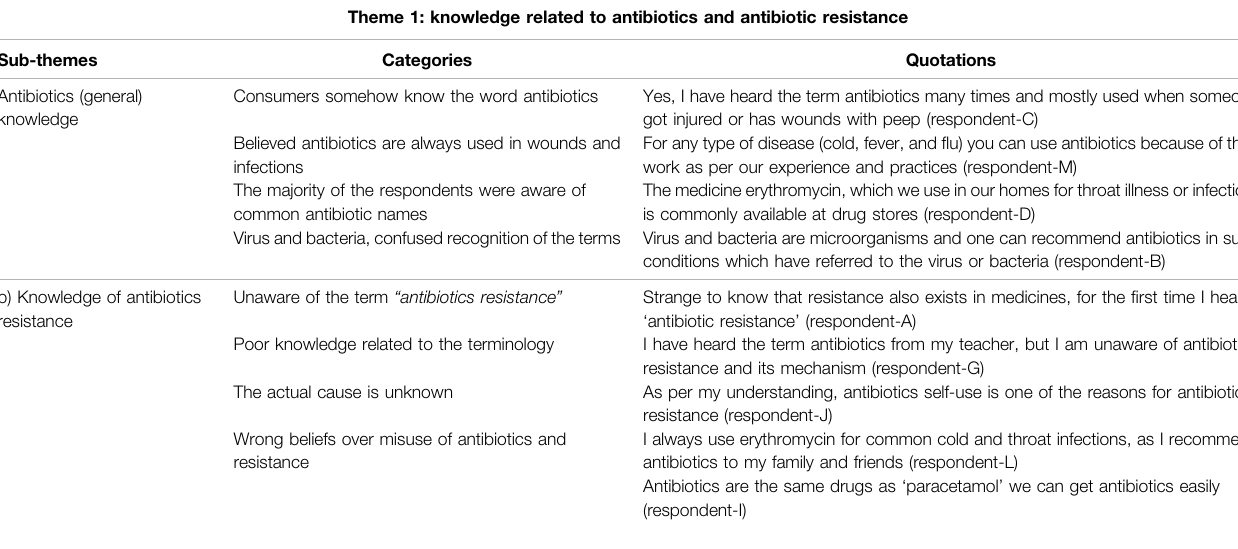
TABLE 3 | Participants ’ knowledge related to antibiotics and ABR.